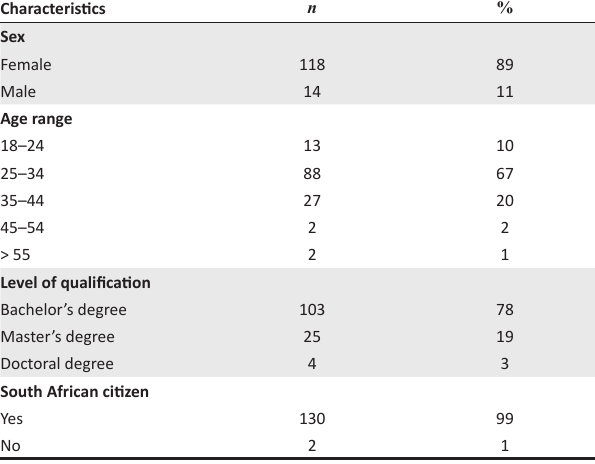
TABLE 1: Participant demographic information ( n = 132).